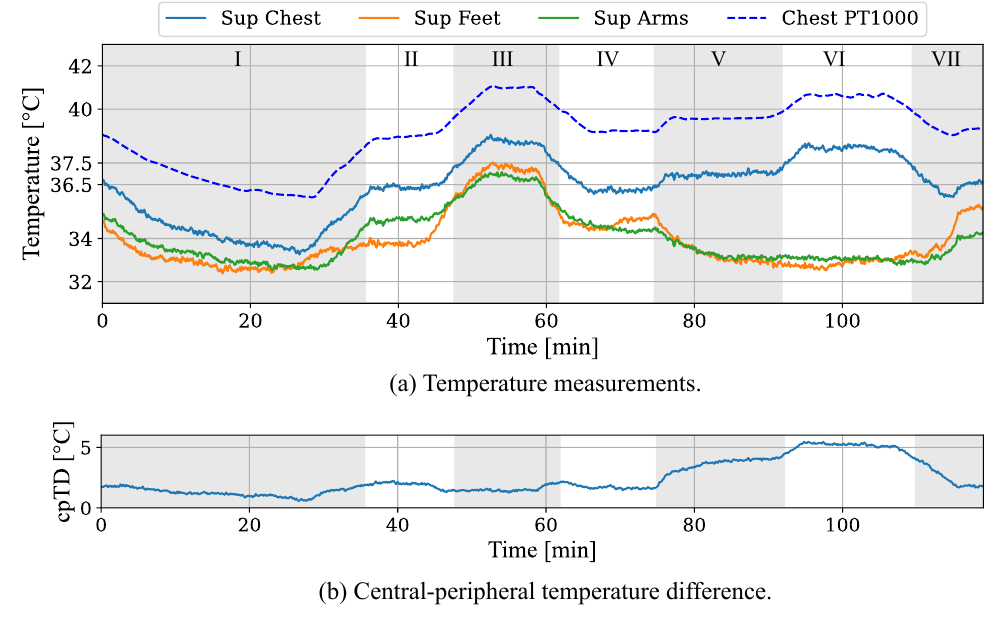
Figure 9. ( a ) Results for temperature measurements of camera-based setup and internal Pt1000 sensor. ( b ) Resulting central-peripheral temperature